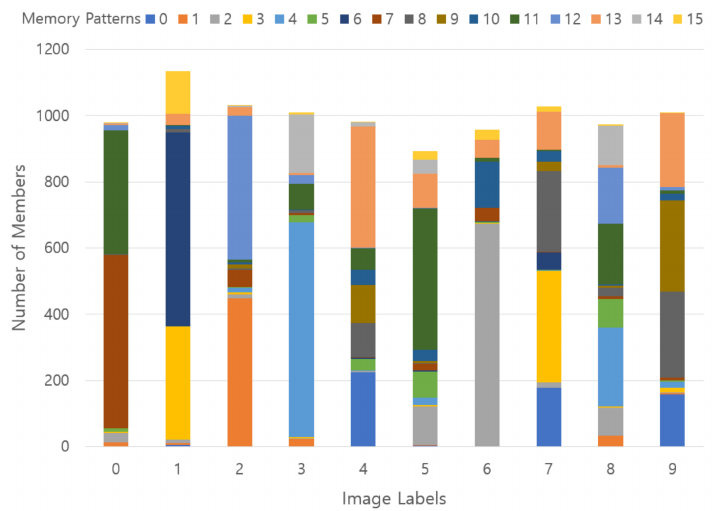
Figure 18. Results of stored memory pattern in an experiment using 20% SDR overlap without the pre-memory process; x -axis represents a ground-truth label, y -axis describes the number of members belonging to each label, and a vertical color code indicates a memory pattern ratio belonging to each ground-truth